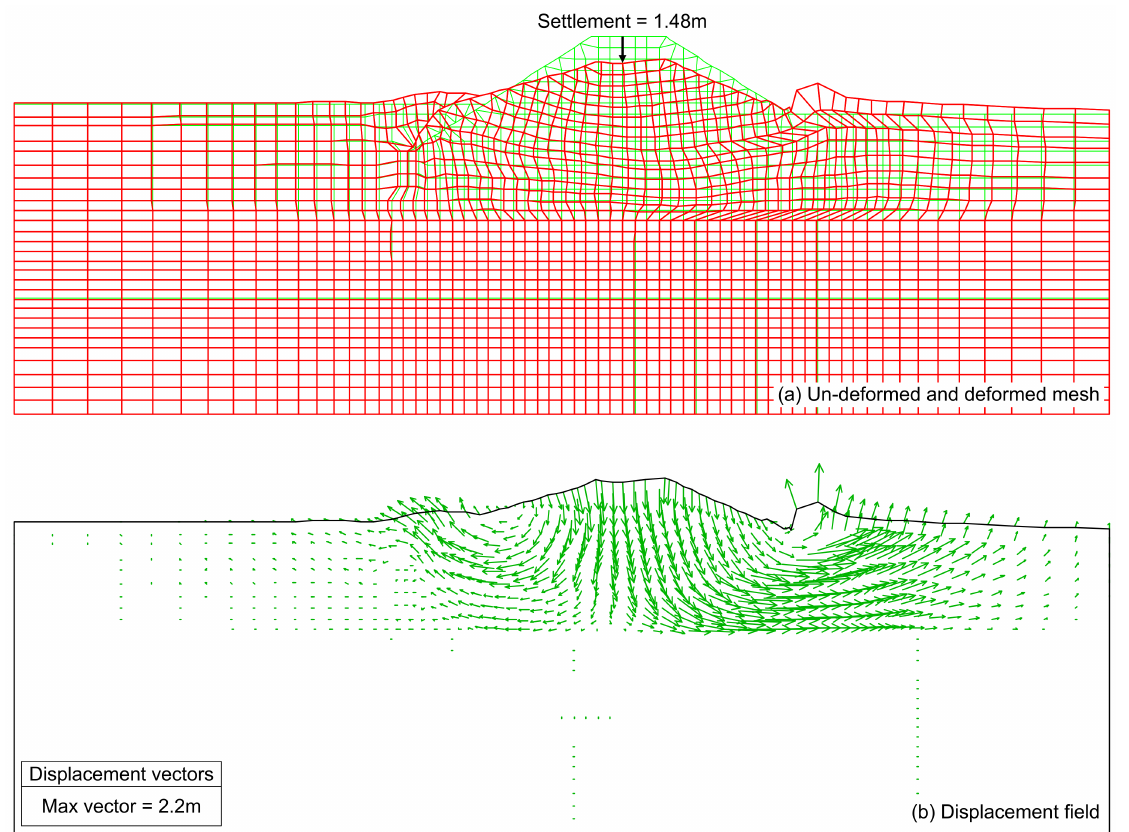
Figure 15. The SSM results of the embankment with the lower relationship weakening parameters suggested by Stark and Mesri